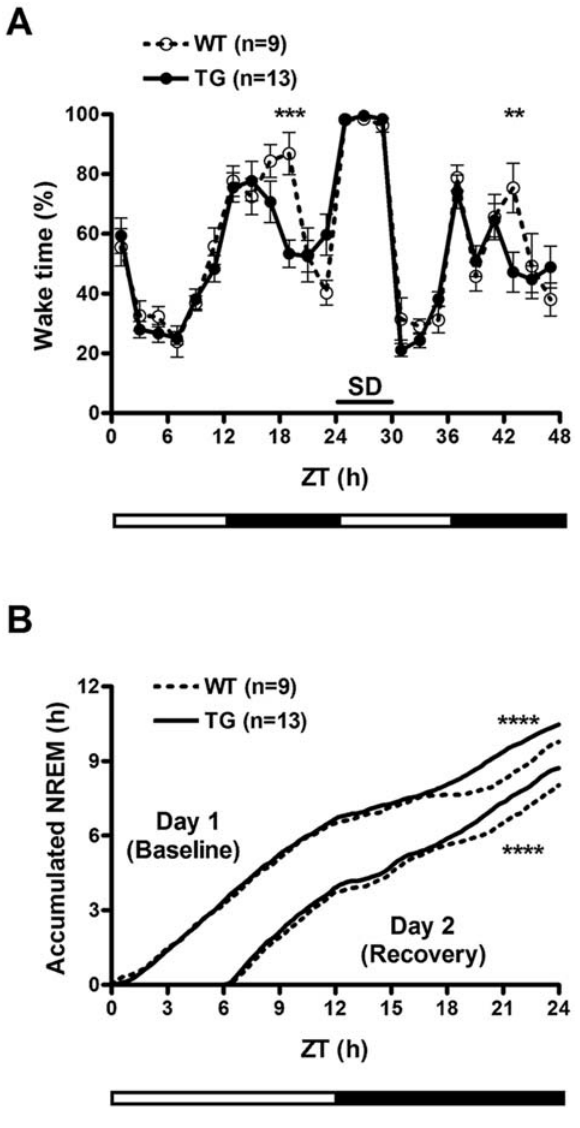
Figure 4. Decreased wakfeluness in human IGFBP3 transgenic mice. (A) Wakefulness is decreased in the second half of the dark/active period in human IGFBP3 transgenic mouse (h IGFBP3 TG) versus wild type littermates (WT). Reduced sleep rebound is also observed at the same Zeitgeber times (ZT) after sleep deprivation. (B) Cumulative NREM plots at baseline and during recovery after 6 hours of sleep deprivation. Note increased sleep in IGFBP3 transgenic mice in the second half of the active period, ZT17-24. **: p , 0.01 versus WT; ***: p , 0.001 versus WT. Temperature and locomotion were also affected, see Fig. S2.